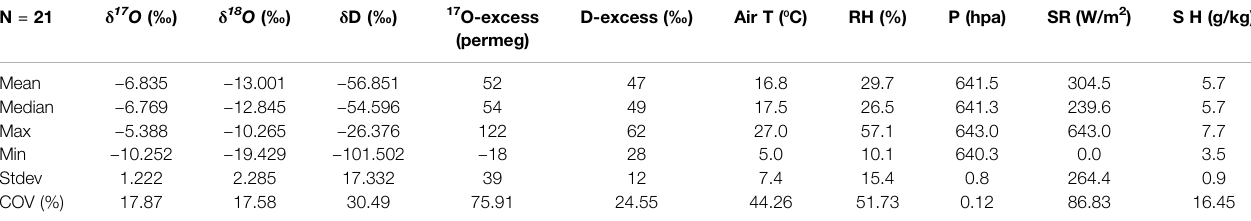
TABLE 2 | Summary of triple oxygen isotopes and meteorological parameters of entire vapor samples of Chhota Shigri glacier, western Himalaya. N =